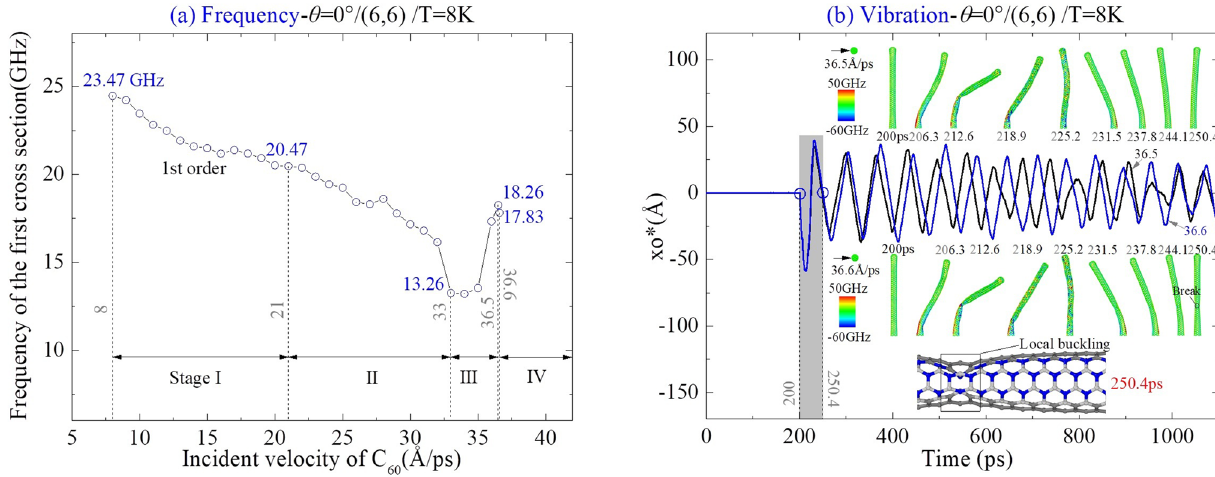
Figure 7. Vibration analysis of (6,6) the nanobeam impacted by C 60 along the path of θ = 0° at 8 K. ( a ) Natural frequency of the beam versus the incident velocity of C 60 . ( b ) Vibration curves of cross section 1 when the incident velocity is nearby MIV_D = 36.6 /ps, Breakage of bond appears between cross Sects. 11 and 12. Snapshots of beam are Å